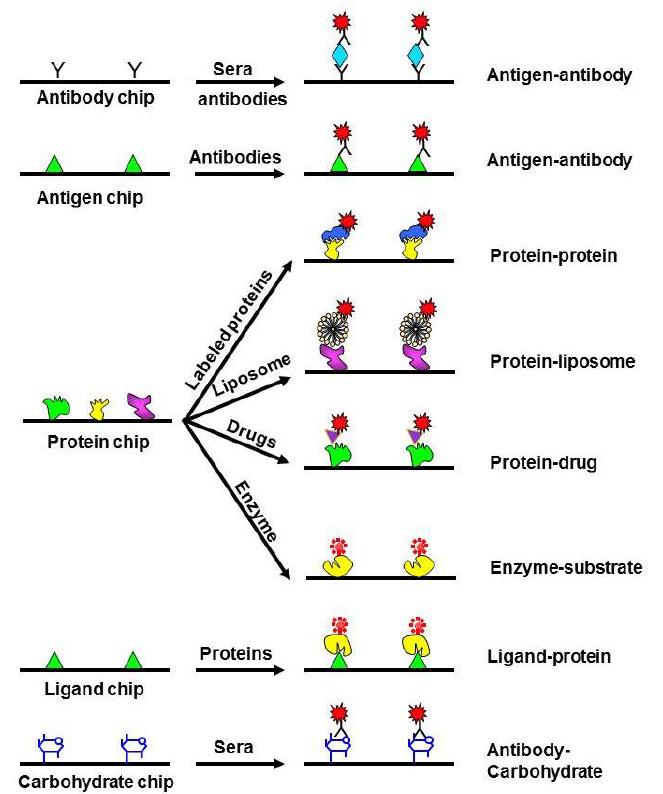
Figure 4. Applications of protein arrays. Analytical microarrays consist of a high-density array of affinity reagents, such as antibodies or antigens; they can also involve the use of ligands or carbohydrates. On the other hand, functional microarrays are made by immobilizing high numbers of purified proteins. Reprinted with permission from [117], Copyright (2003) Elsevier Science Ltd.